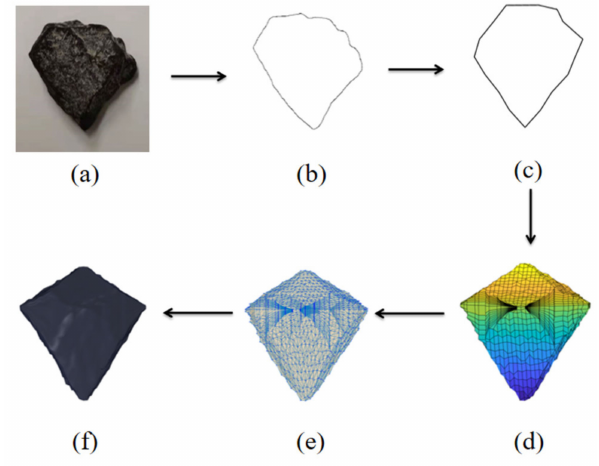
Figure 1. Single concrete aggregate generation, ( a ) the real aggregate; ( b ) contour extraction; ( c ) the reconstructed aggregate; ( d ) closing surfaces; ( e ) Delaunay triangulation; ( f ) mesoscopic model of aggregate.